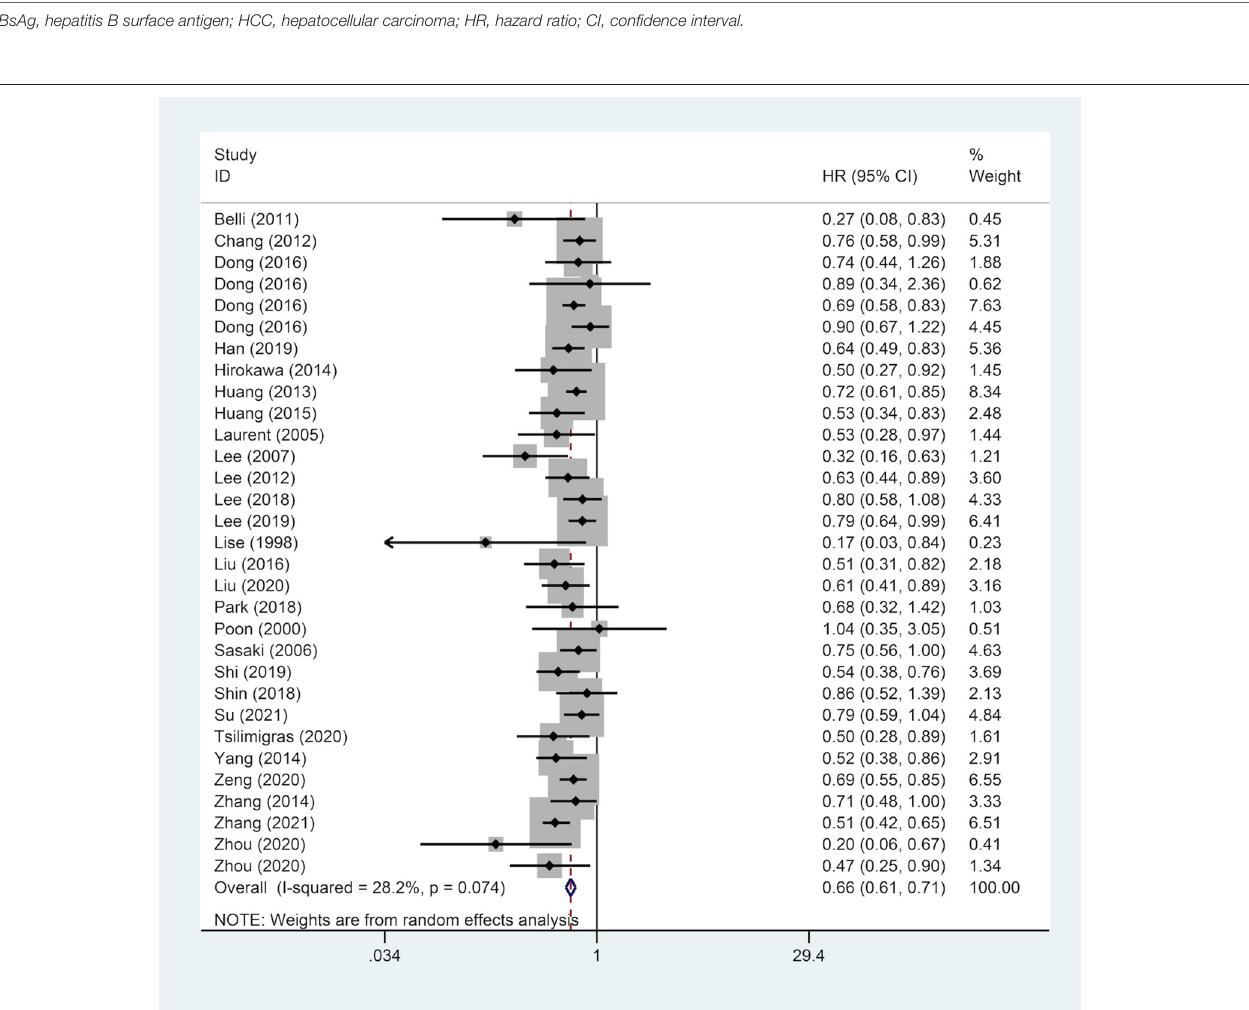
Frontiers in Surgery |